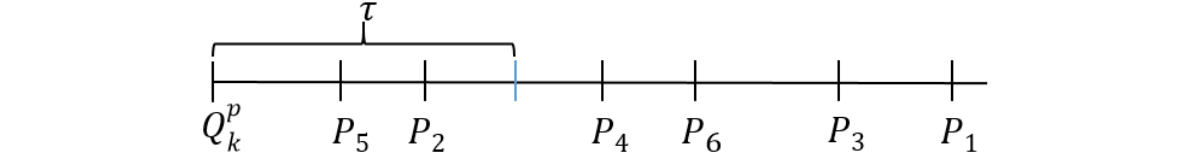
Figure 2. Dissimilarities of electronic health record prefixes with respect to the k-events prefix of a patient Q denoted by Q_k p